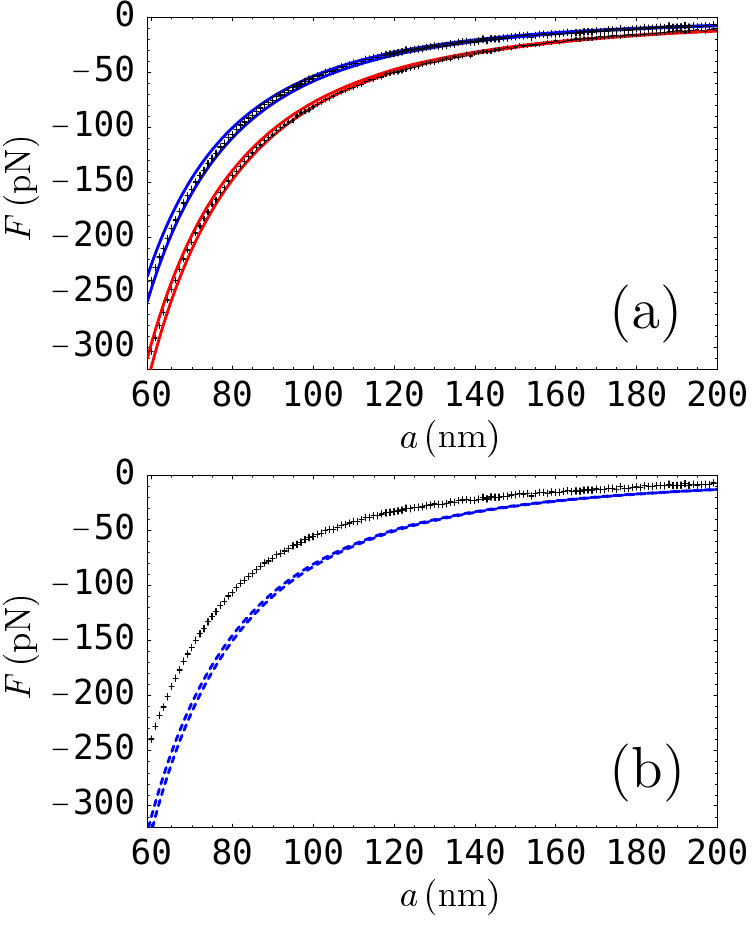
Figure 6. The Casimir forces between an Au-coated sphere and an ITO-coated plate measured using an atomic force microscope are shown as crosses [40,41]. ( a ) The lower and upper sets of crosses represent the measurement results before and after a UV irradiation of the ITO film. The red and blue theoretical bands are computed including and omitting free charge carriers, respectively. ( b ) The set of crosses represents the measurement results after UV irradiation of ITO film. The blue theoretical band is computed with taken into account free charge carriers in